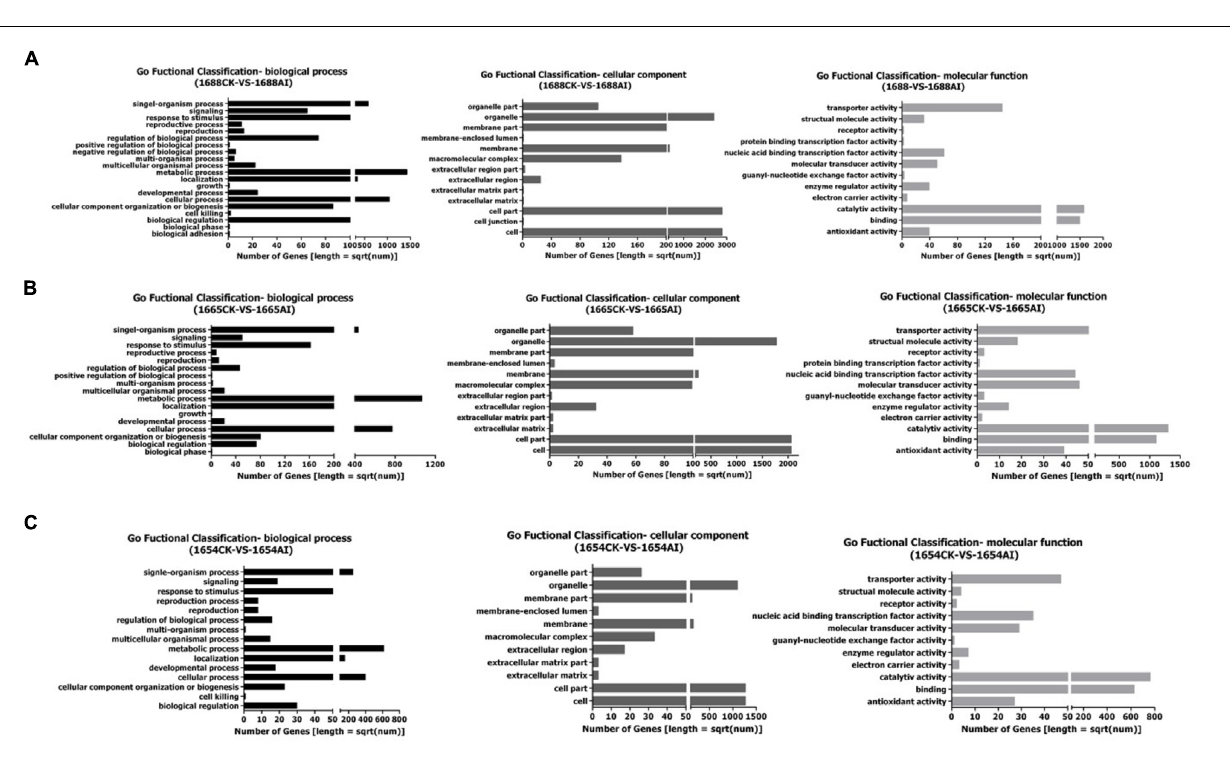
The DEGs are divided into 45 sub-categories,